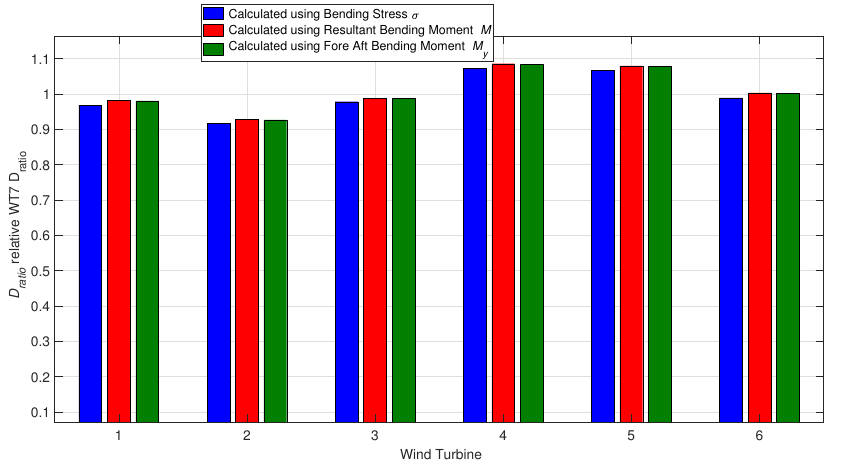
Figure 23. Normalised D ratio calculated using bending stress σ , resultant bending moment M and fore-aft bending moment M y for a range of wind turbines. The percentage differences between the estimates for the relative ratio, D ratio , using the resultant bending moment, M , and the fore-aft bending moment, M y , relative to the relative estimates using the bending stress, σ , are shown in Figure 24.